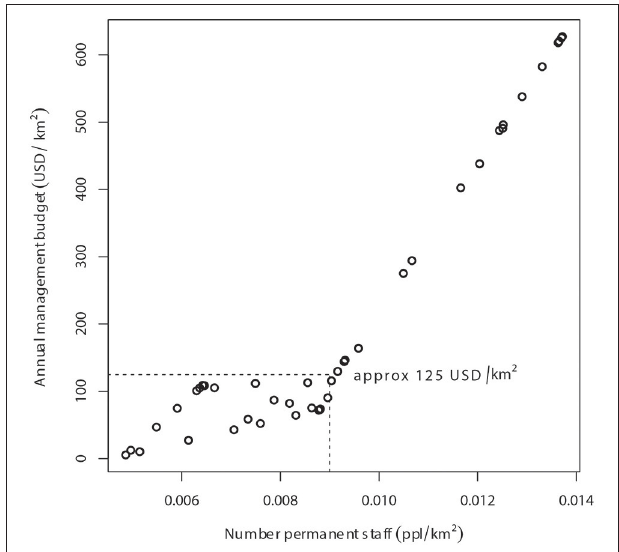
FIGURE 6 | Relationship between annual management budget (USD/km 2 ) and number of permanent staff per km 2 in the WAP Complex. At the level of staffing that results in 80% probability of lion occupancy (9 persons per 1000 km 2 , or 0.009 persons per km 2 ), annual management budget in WAP is approximately 125 USD/km 2